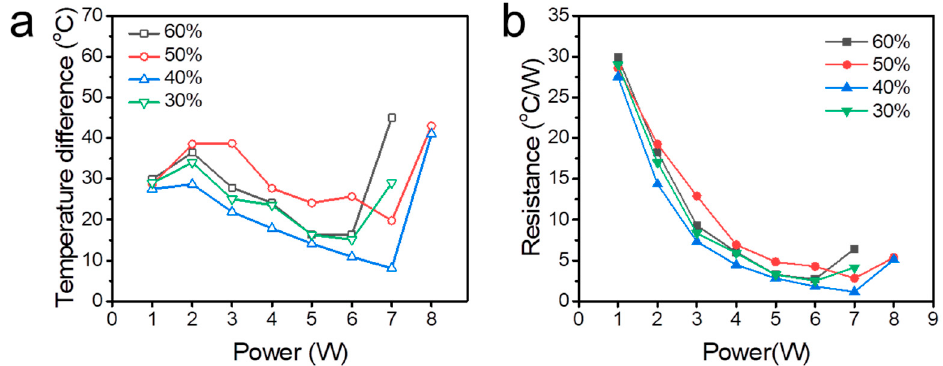
Figure 5. Thermal performance of the FOHP. ( a ) Temperature difference and ( b ) thermal resistance evolution with different heating power inputs.